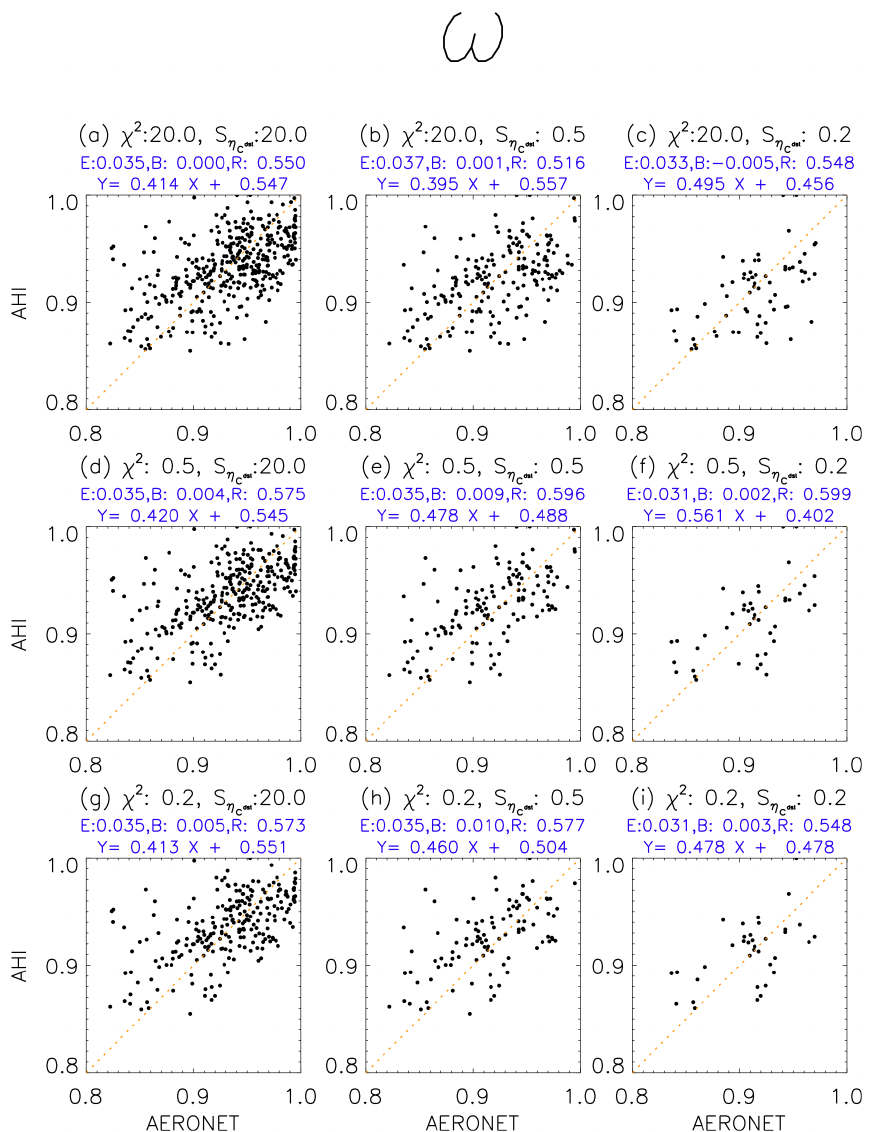
Figure 10. Frequency distribution of ω retrieved from AHI and those from AERONET. The results retrieved from this algorithm in the case of χ 2 less than 20, 0.5, and 0.2 and uncertainties of the retrieved η dst c ( S η dst above the figures are the same as in Fig.